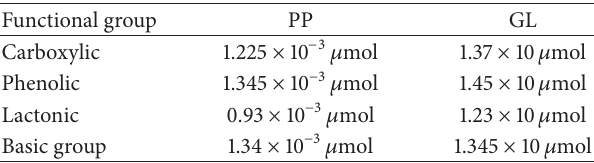
Table 2: Identification and calculation of oxygen containing func- tional